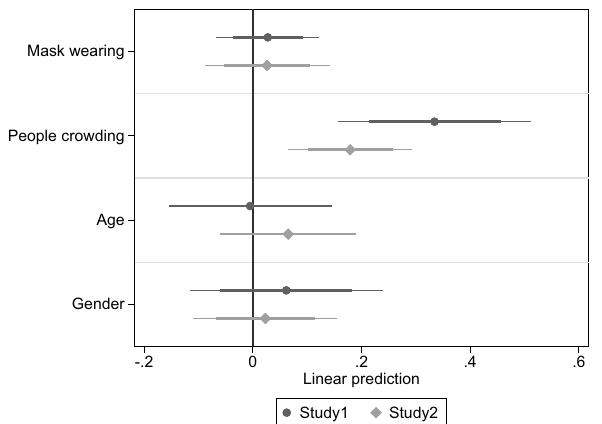
Figure 1. Regression analyses of observational data of social distancing violations in Study 1 and Study 2. Note. Linear probability model estimates, with 95% and 99.5% confidence intervals (two-tailed). All models controlled for the time duration of each observation. The continuous age and crowding items were standardized to make them comparable to binary predictors 59